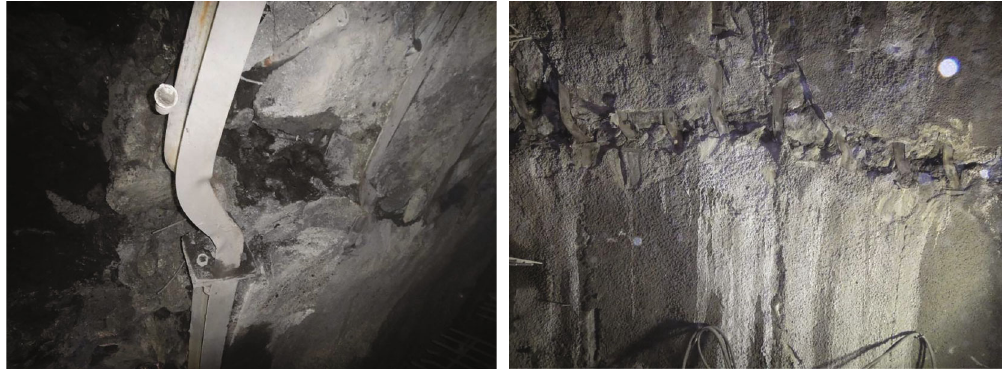
Figure 2: Distortion and spalling of shotcrete of steel frame for initial support of